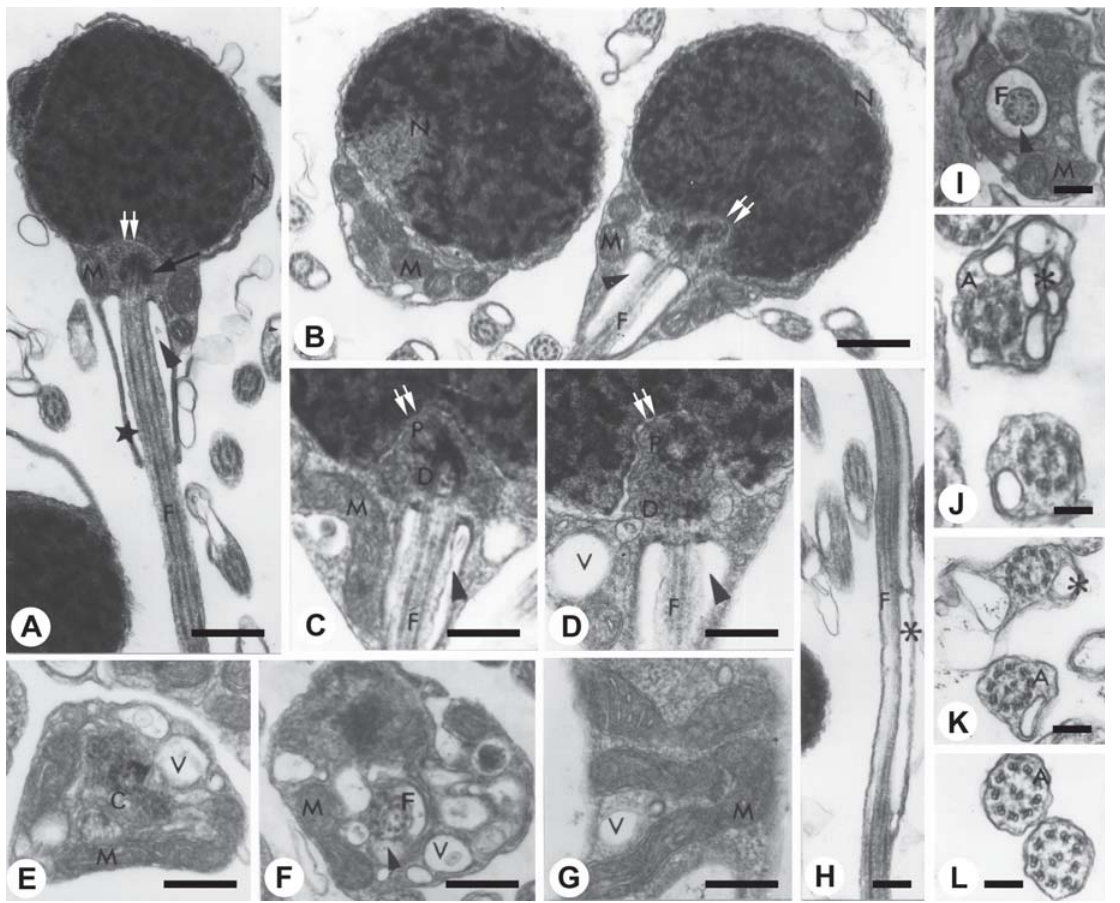
Fig. 5. Metynnis mola spermatozoa. A and B - Spermatozoa in longitudinal sections. C and D - Longitudinal sections of the nuclear fossa region. E to H - Midpiece in cross sections. I - Flagellum in longitudinal section. J, K and L - Flagella in cross sections. Scale bars, A = 0.6 µ m; B = 0.55 µ m; C = 0.4 µ m; D = 0.35 µ m; E= 0.5 µ m; F = 0.4 µ m; G = 0.35 µ m; H = 0.25 µ m; I = 0.35 µ m; J - K = 0,15 µ m; L = 0.1 µ m. A: axoneme; C: centriole; D: distal centriole; F: flagellum; M: mitochondria; N: nucleus; P: proximal centriole; V: vesicle; Asterisk: tubule-vesicular compartment; Arrow: electron dense material; Arrowhead: cytoplasmic canal; Double arrow: nuclear fossa; Star: cytoplasmic